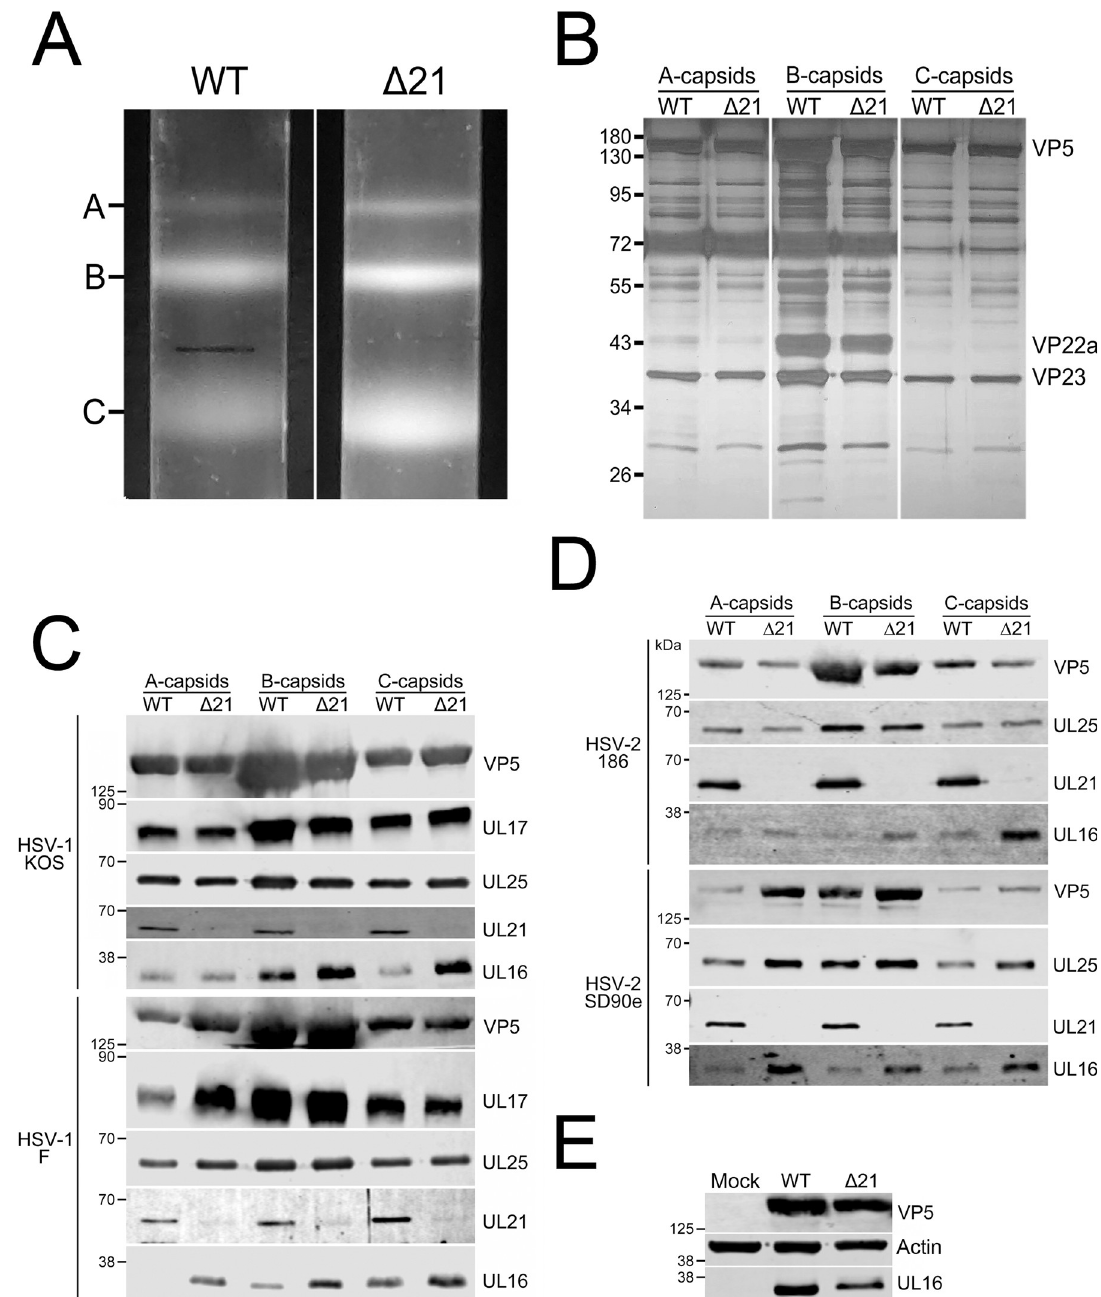
Fig 6. Isolation and analysis of HSV WT and Δ 21 nuclear A-, B-, and C-capsids. Nuclear capsids were isolated from Vero cells infected with HSV-1 or HSV-2 WT and corresponding Δ 21 strains. A) Light scattering bands observed in 20–50% sucrose gradients used to resolve A-, B- and C-capsids isolated from cells infected with WT and Δ 21 HSV-1 KOS. B) Nuclear capsid-containing gradient fractions from WT and Δ 21 HSV-1 KOS infected cells were electrophoresed through an SDS-PAGE gel and silver-stained to identify proteins associated with A-, B-, and C-capsids. VP5 and VP23 can be clearly seen in all samples, while VP22a is only seen in WT and Δ 21 B-capsid fraction samples. No obvious differences were observed between WT and Δ 21 A-, B-, and C-capsids . C and D) Western blot analysis of HSV-1 (KOS, F) (three and two biological replicates, respectively) and HSV-2 (186, SD90e) (one and two biological replicates, respectively). WT and Δ 21 A-, B-, and C-capsid fractions probed with antisera, indicated on the right side of each panel. Migration positions of molecular weight markers (kDa) are indicated on the left side of each panel. E) Vero cells were mock-infected or infected with HSV-1 KOS WT or Δ 21 strains (MOI 3). At 18 hpi, cell lysates were analyzed by western blotting using the antisera indicated on the right side of each panel. The migration position of molecular weight markers (kDa) are indicated on the left side of each panel. Three biological replicates were examined. https://doi.org/10.1371/journal.ppat.1010969.g006 PLOS Pathogens| https://doi.org/10.1371/journal.ppat.1010969 November 14,